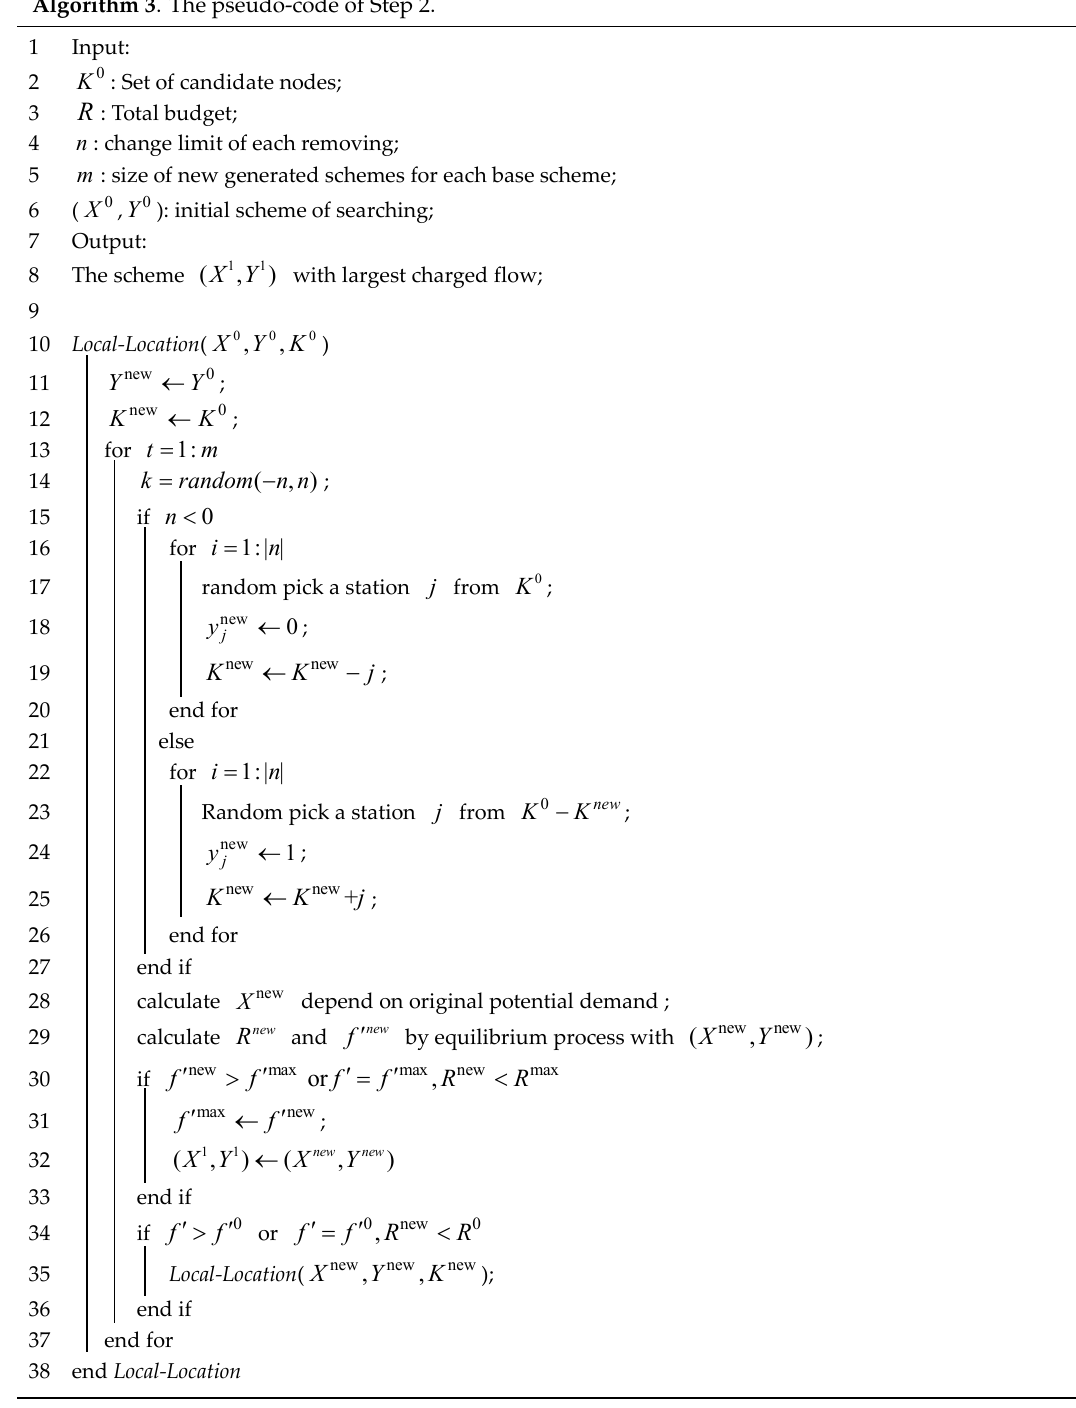
Algorithm 3 . The pseudo-code of Step 2.